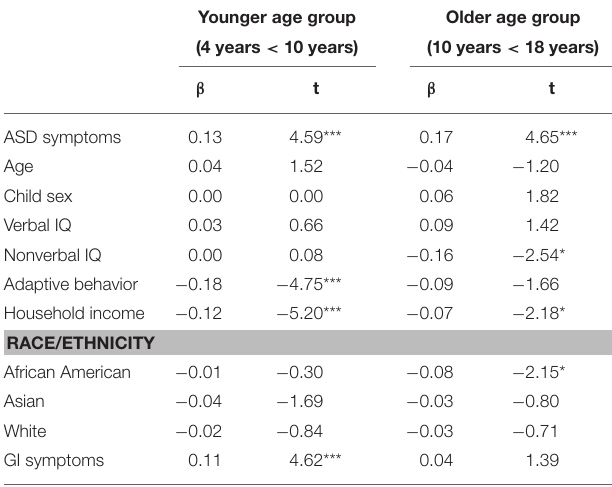
TABLE 5 | Unique contributions of child and family factors to self-injurious